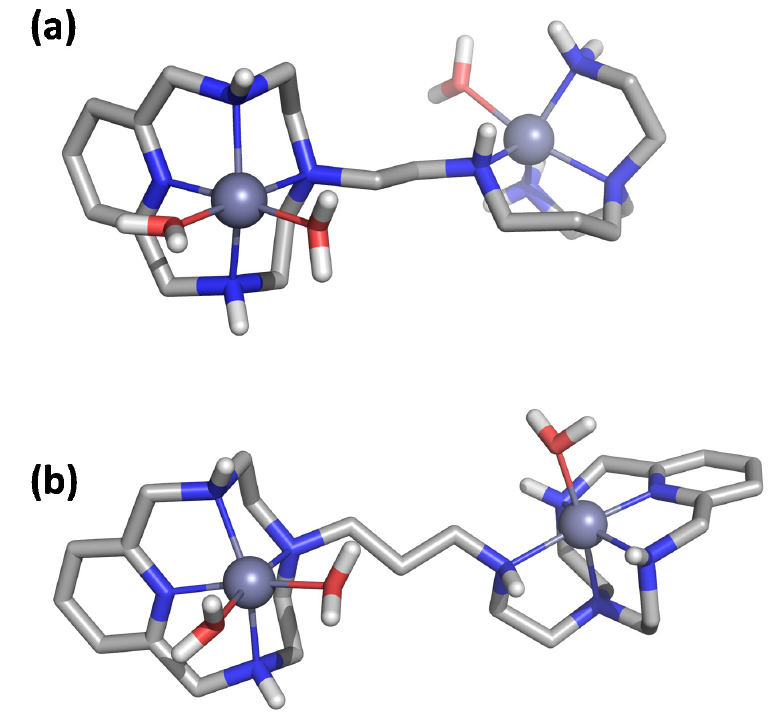
Figure 2. Visualization of the minimum energy structure optimized by DFT for the complex Zn 2 L1 4+ ( a ) and Zn 2 L2 4+ ( b ). ( a ) and Zn 2 L2 4+ ( b